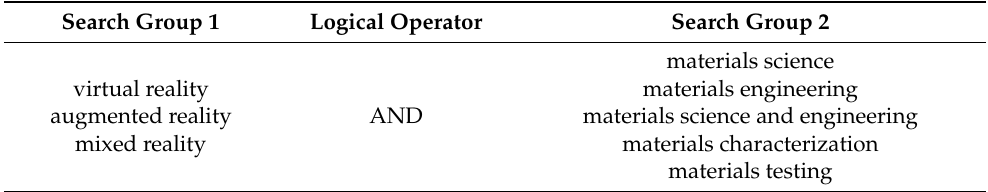
Table 1. The basic structure of the search strings. The search shall return results with one or more of the terms contained in Search Group 1 and one or more terms contained in Search Group 2.